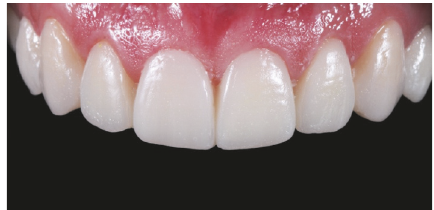
Figure 5: Mock-up with bisacrylic resin (Luxatemp Star A1, DMG). Notice the shape, which is the same as the DSD planning.